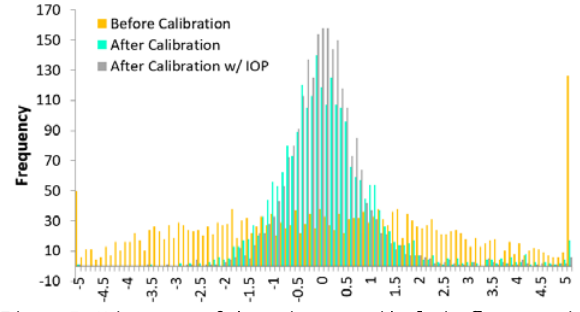
Figure 7: Histogram of the x-image residuals in fluoroscopic system 2